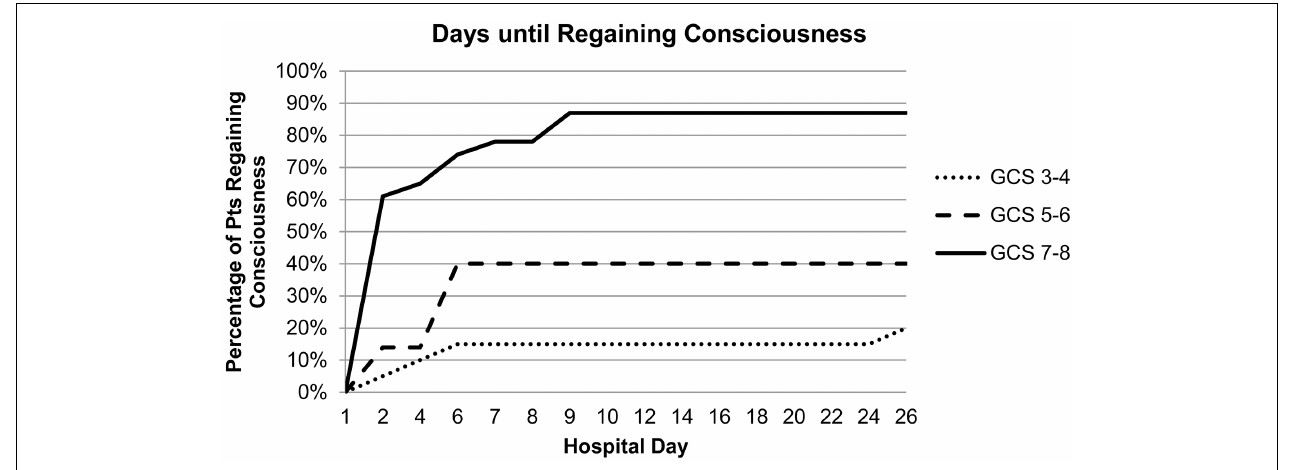
FIGURE 1 |Admission GCS category and number of hospital days until awakening from coma .